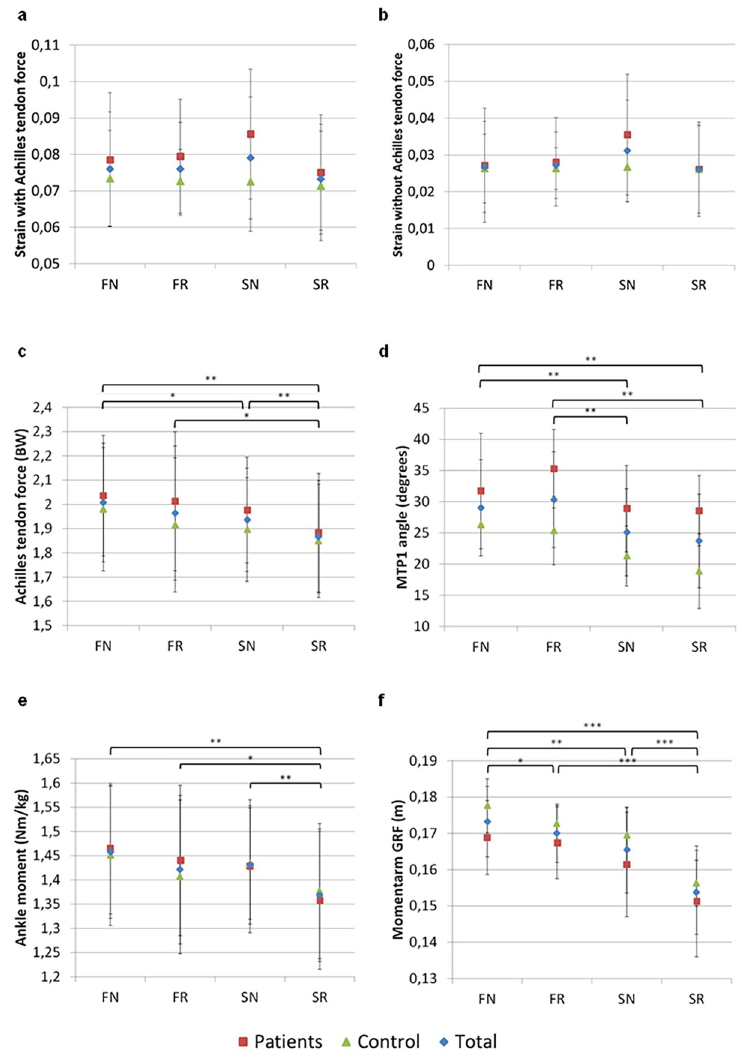
Fig 4. Effects of shoe conditions on biomechanical variables. Average values for PA strain with (a) and without (b) Achilles tendon force, MTP1 angle (c), Achilles tendon force (d) and plantarflexion moment (e) at peak loading and moment arm of GRF at heelrise (f) ( � p < .05; �� p < .01; ��� p <